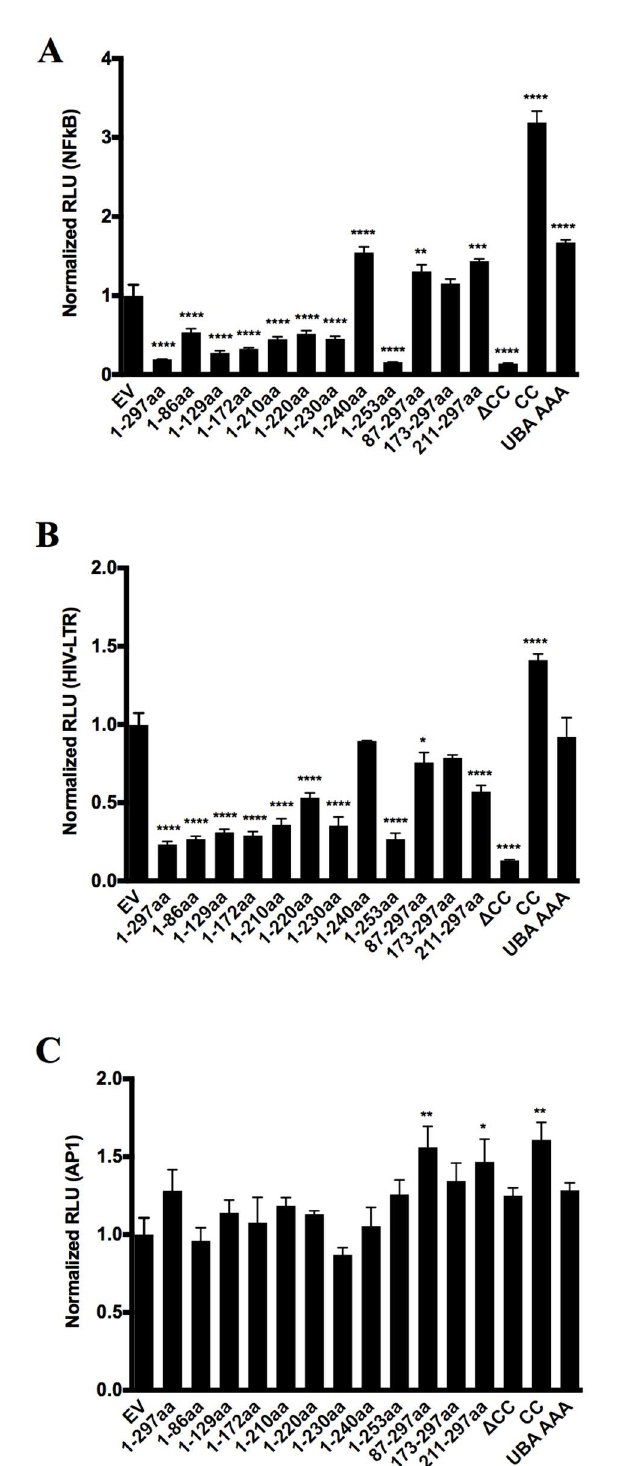
Fig 2. Characterization of UBXN1 functional domains by reporter assay. (A) Quantification of NF κ B-FFLUC reporter in HEK293 cells 48 h after 96-wellformat transfectionwith indicatedMyc-UBXN1 constructs (80 ng per well) or empty plasmid(Vector), in the presence5 ng/mL TNF α for 4h; (B) Similar to (A) , using an HIV LTR-FFLUC reporter; (C) Similar to (A) , using an AP1-FFLUC reporter. All data represent mean ± SEM (n = 3). **** p < 0.0001, *** p < 0.0005, ** p < 0.005, * p < 0.05, compared to vector alone,by two-way